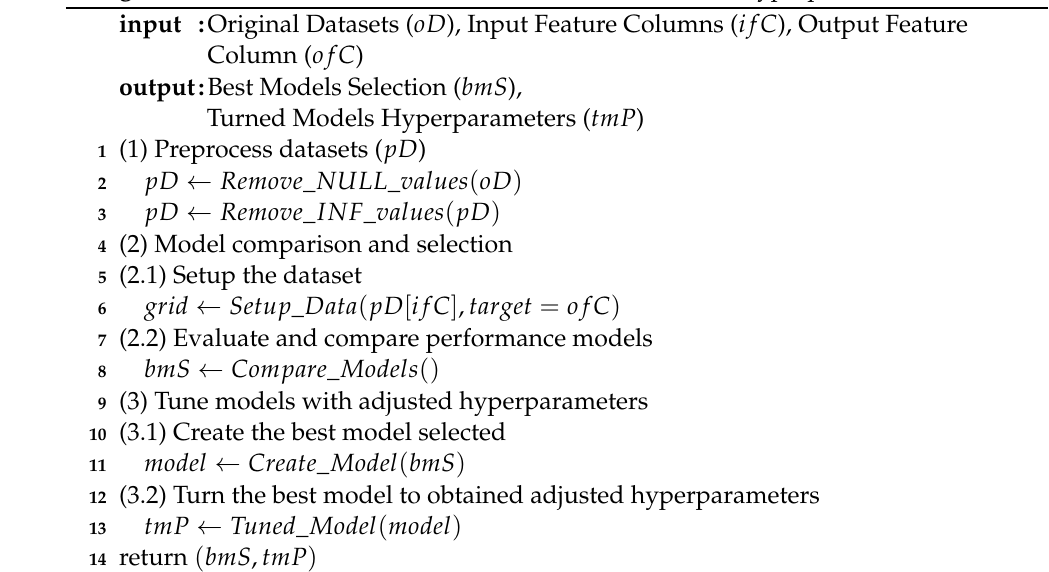
Algorithm 1: The Best Model Selection and Turned Model